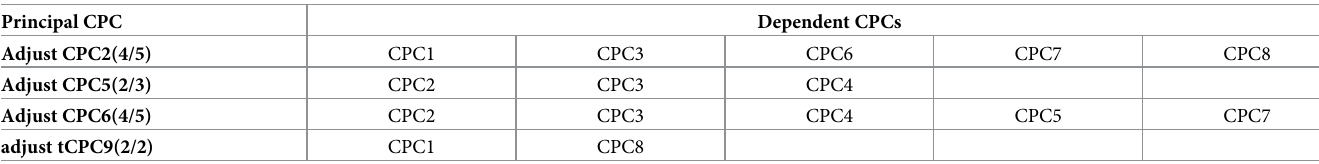
Table 3. Rules for adjusting